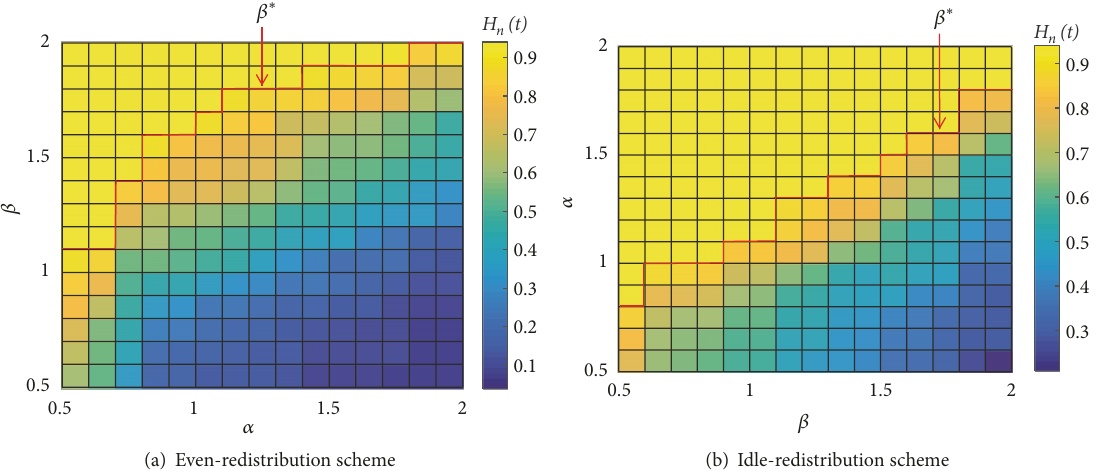
Figure 10: Heatmap of 𝐻 𝑛 (∞) in the parameter space [𝛼, 𝛽] (threshold 𝛽 ∗ is labelled by the red